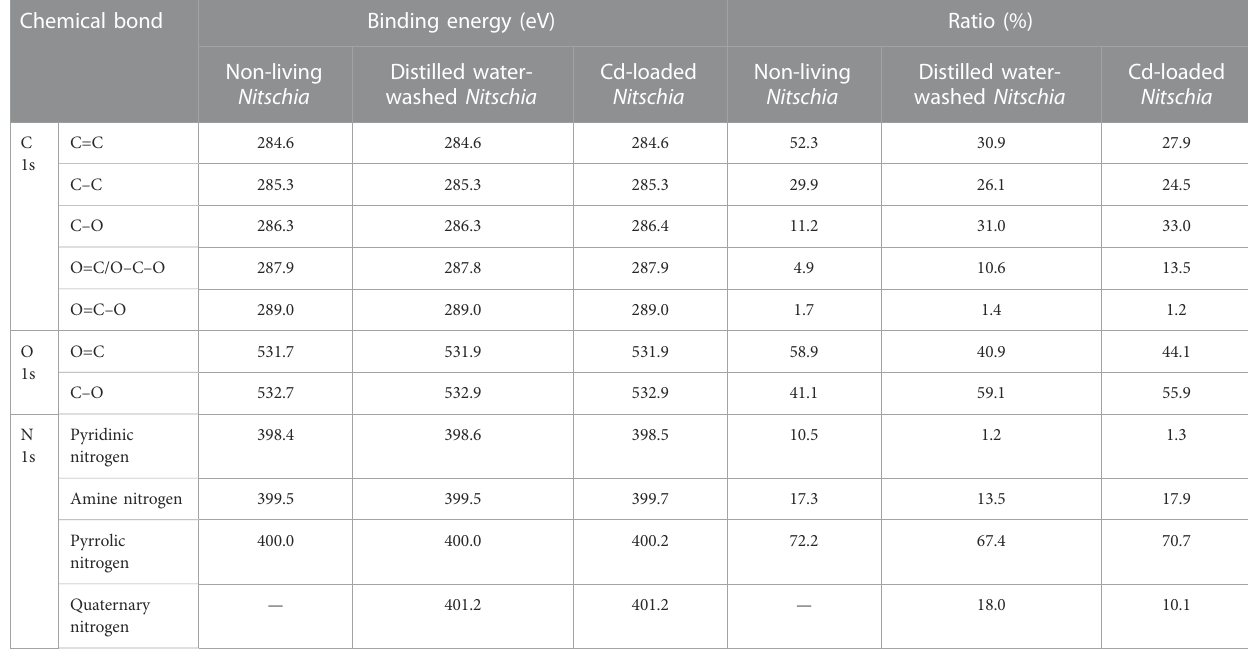
TABLE 4 Summary of binding energy and area ratios of C 1s, O 1s, and N 1s on non-living, distilled water-washed, and Cd-loaded Nitschia biomass. Chemical